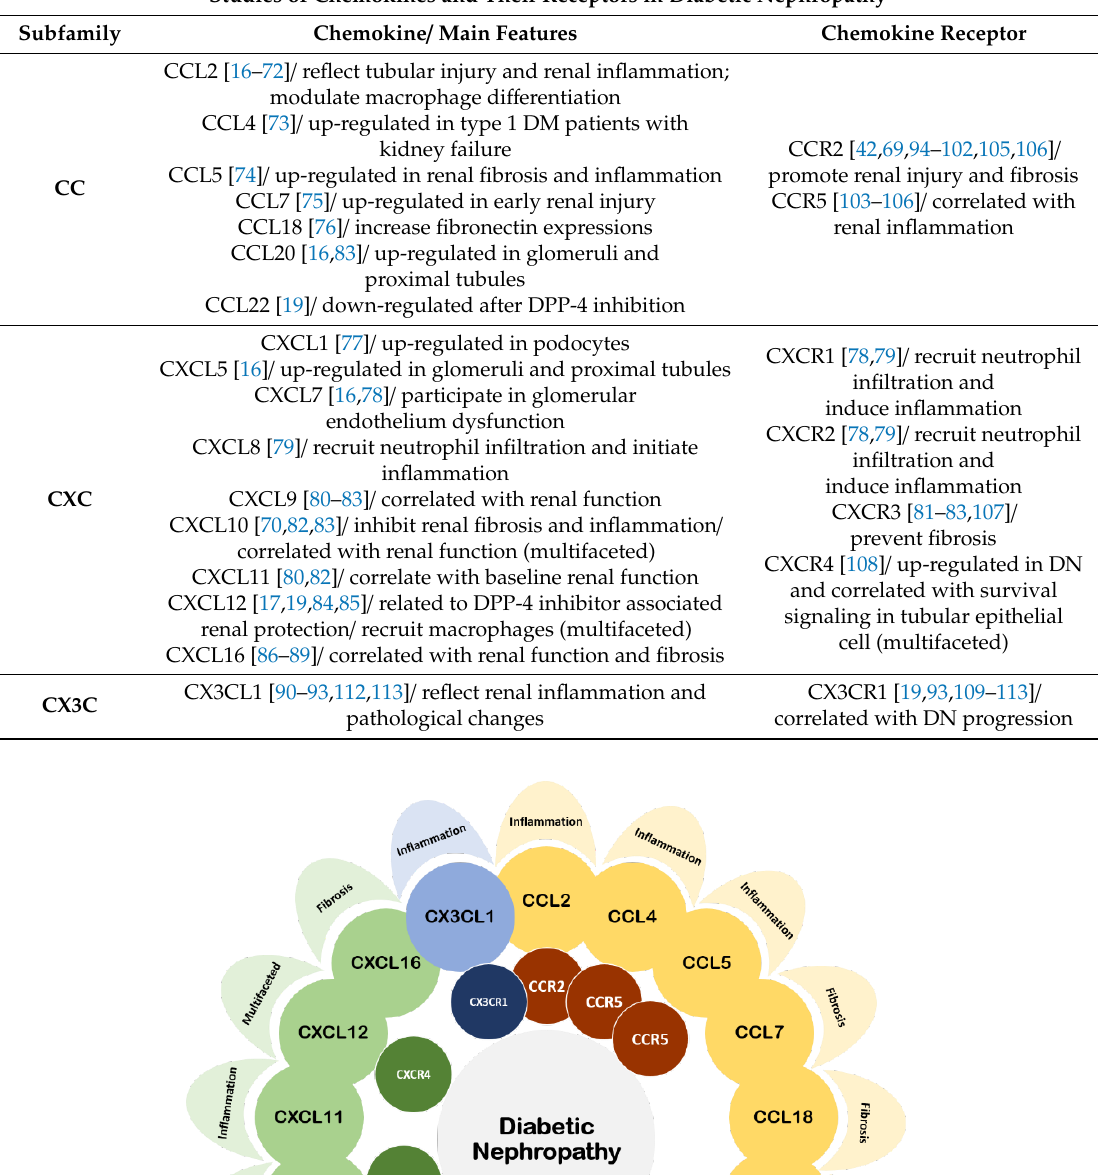
Table 1. Summary of the chemokines and their receptors in diabetic nephropathy discussed in this review article. DM: diabetes mellitus; DN: diabetic nephropathy.